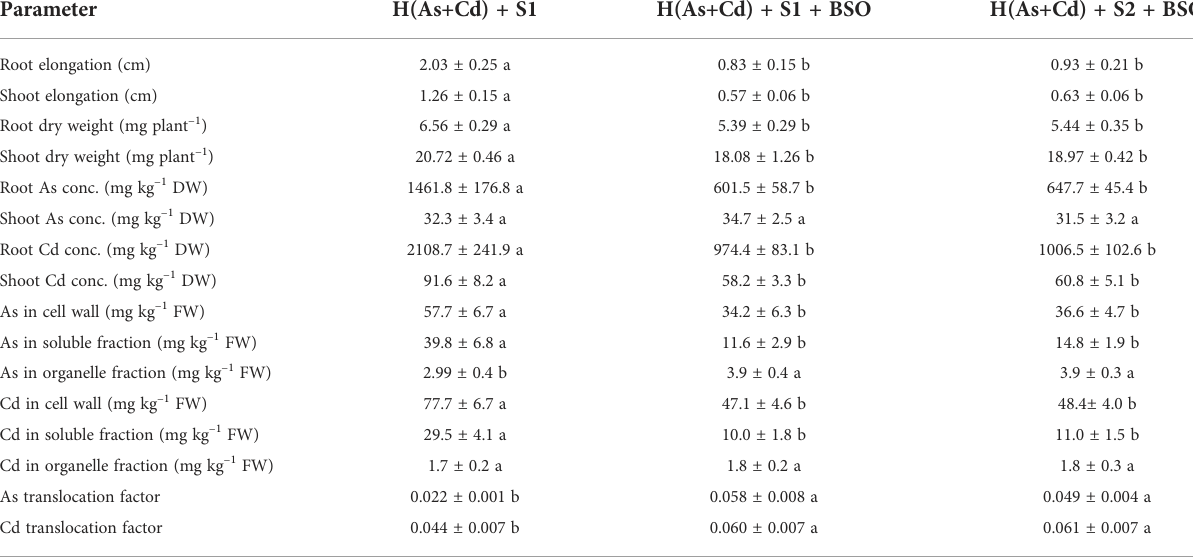
TABLE 4 Plant growth, As and Cd accumulation, the subcellular distribution of As and Cd in roots, and As and Cd translocation from roots to shoots of wheat plants grown in de fi cient S or suf fi cient S nutrient solution after 6 days of exposure to high As plus Cd with or without BSO.